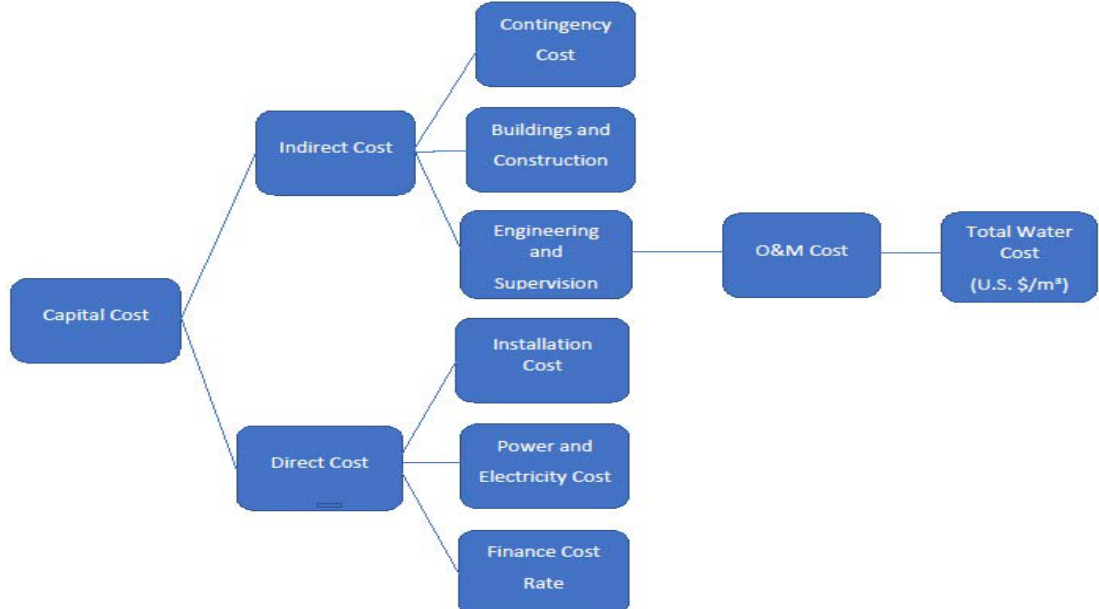
Figure 4. Diagram of total water cost components.